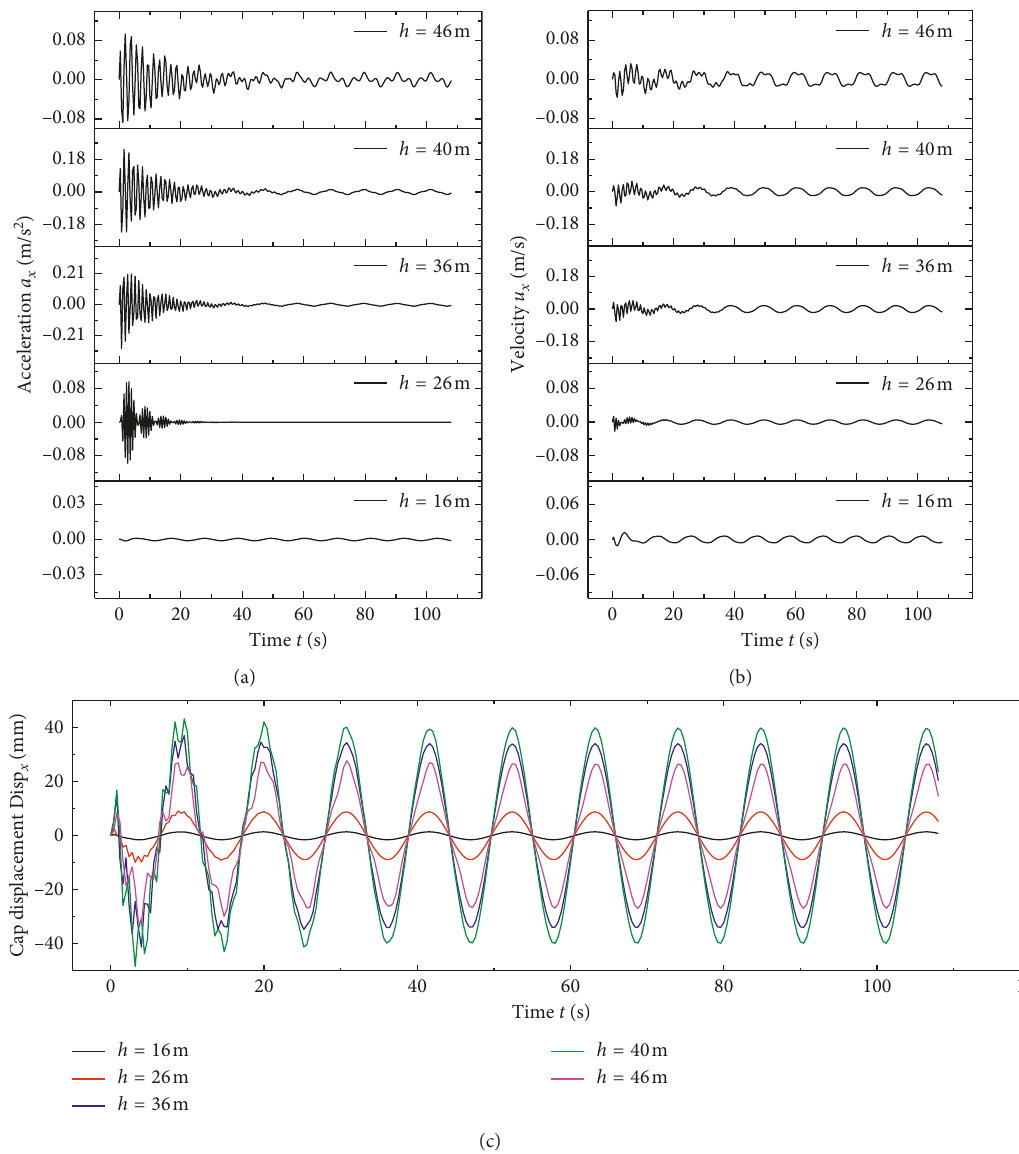
Figure 8: Response time series under the wave. (a) Acceleration. (b) Velocity. (c)